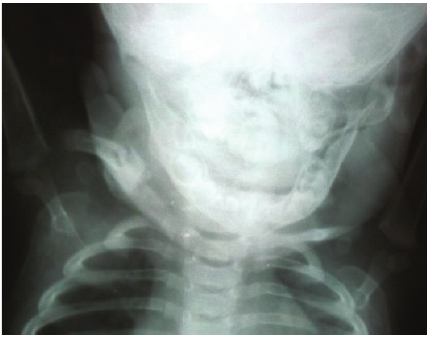
Figure 4: Radiograph six months after operation showing healed osteomyelitis in midshaft of